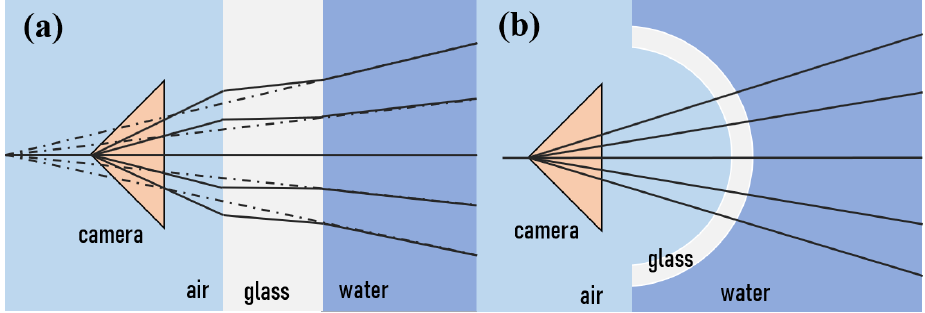
Figure 13. ( a ). Imaging distortion effect of non-domed shape viewport. ( b ). Domed shape viewport will release the imaging distortion effect